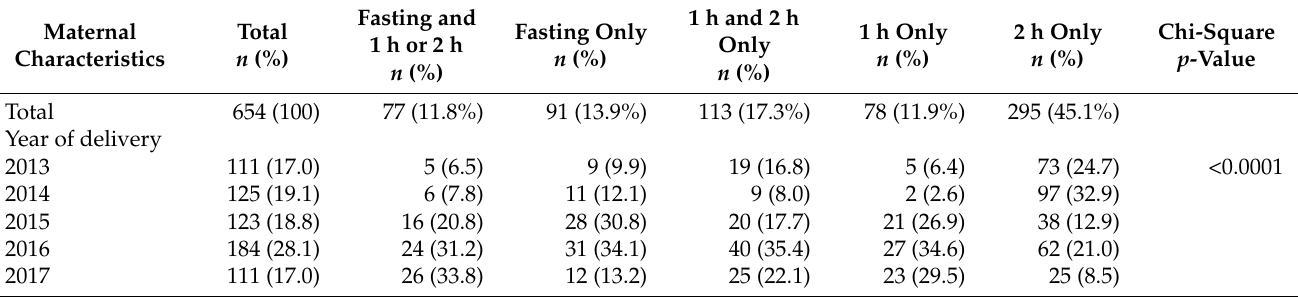
Table 2. Maternal characteristics by combined diagnostic